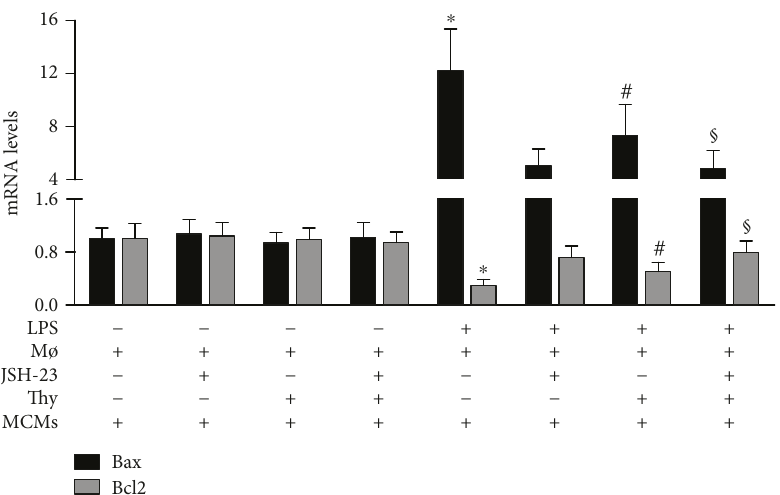
Figure 2: E ff ects of JSH-23 on LPS-induced MCM apoptosis. The Bax and Bcl2 mRNA levels in each group were detected. N = 5 in each group. ∗ P < 0 05 vs. the Mø+MCM group; # P < 0 05 vs. the LPS+Mø+MCM group; § P < 0 05 vs. the LPS+Mø+MCMs+Thy